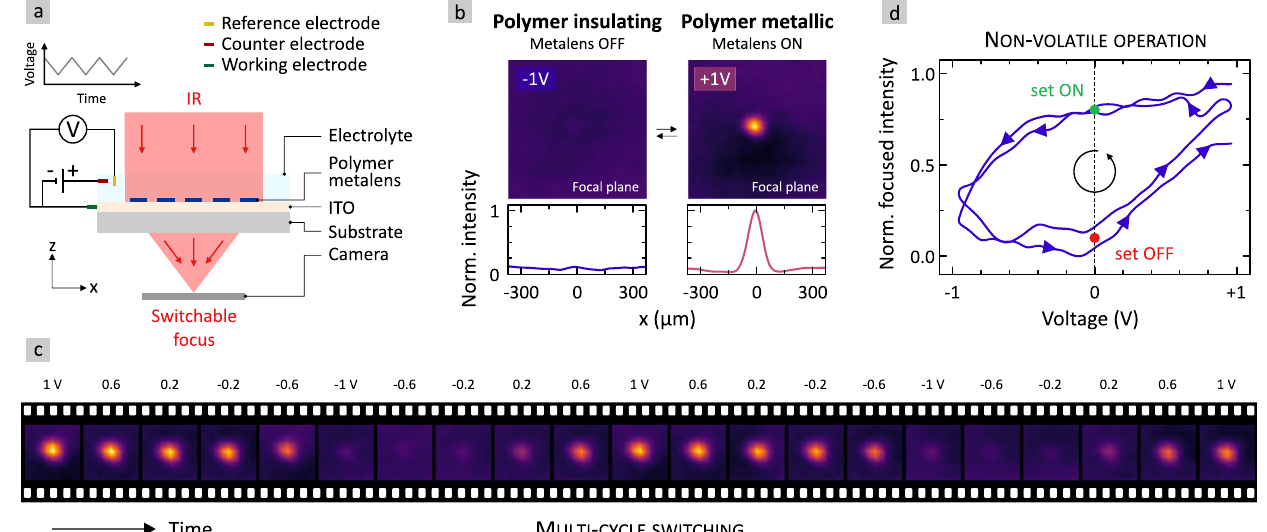
Fig. 3 | High-contrast electrical switching of a metallic polymer metalens-on- demand. a Setup to electrically switch a metalens. An electrochemical three- electrode setup is used to tune the applied voltage via cyclic voltammetry. The camera is placed in the focal plane of the metalens (focal length of f =5mm) to image the optical performance of the metalens. b Camera images and cross- sectional intensity pro fi les in the focal plane of the metalens. Left: An applied voltage of − 1V switches the polymer insulating and thus the metalens OFF with no diffractive power. Right: A voltage of +1V switches the polymer metallic and the metalens ON. A focus is observed. c Time sequenceofcamera images showing the